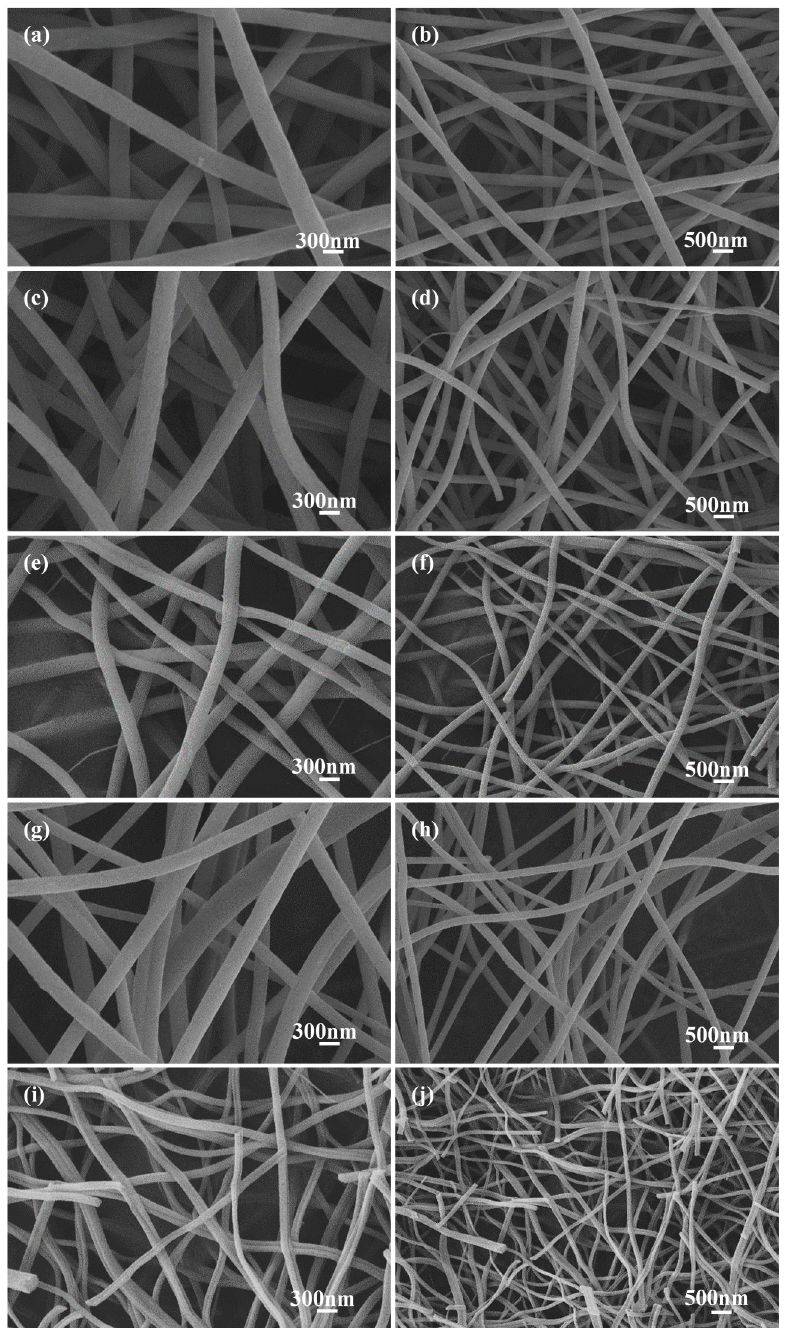
Figure 2. SEM images of carbon fiber membrane based on potassium citrate/PAN: ( a , b ) C − 0, ( c , d ) C − 0.25, ( e , f ) C − 0.5, ( g , h ) C − 1, ( i , j ) C − Table 1. The BET surface area of carbon fiber membrane based on potassium citrate/PAN. Samples